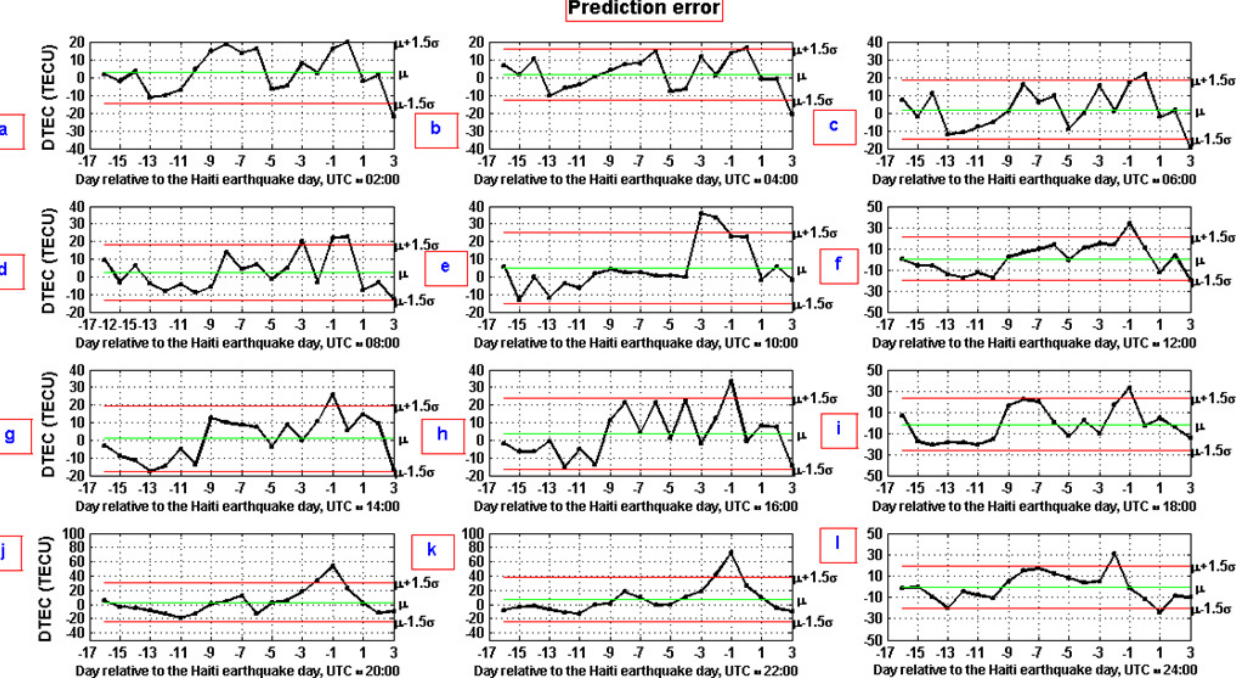
Fig. 7. Variations of the differences between the observed and the predicted values of TEC on days selected as testing set at different universal times. The x-axis represents the day relative to the Haiti earthquake day.